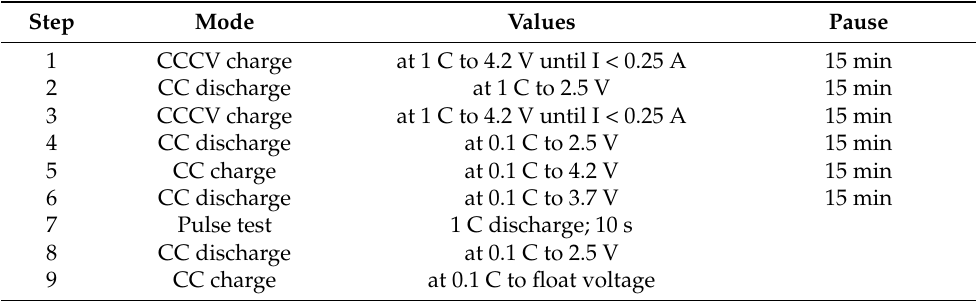
Table 2. Check-up